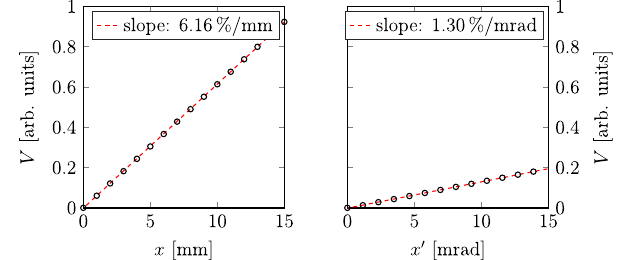
FIG. 3. Geometry and orientation of the higher-order mode (upstream and downstream) and fundamental power coupler (downstream).